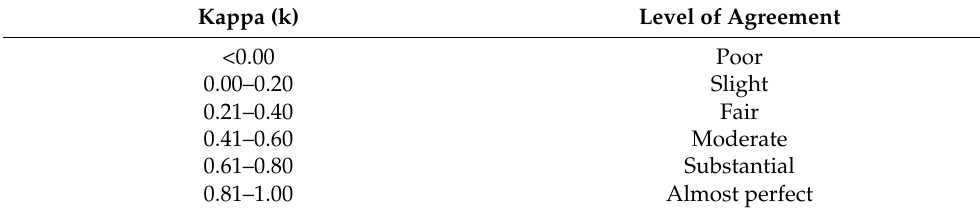
Table 2. Ranking criteria of kappa